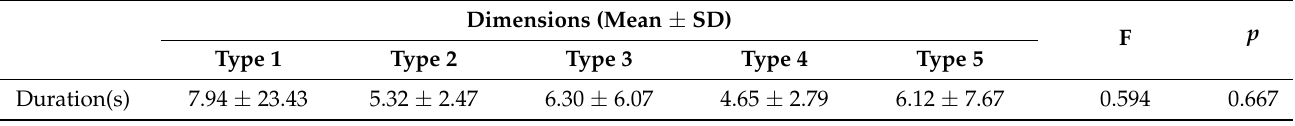
Table 21. Analysis of variance in decision-making time for different button